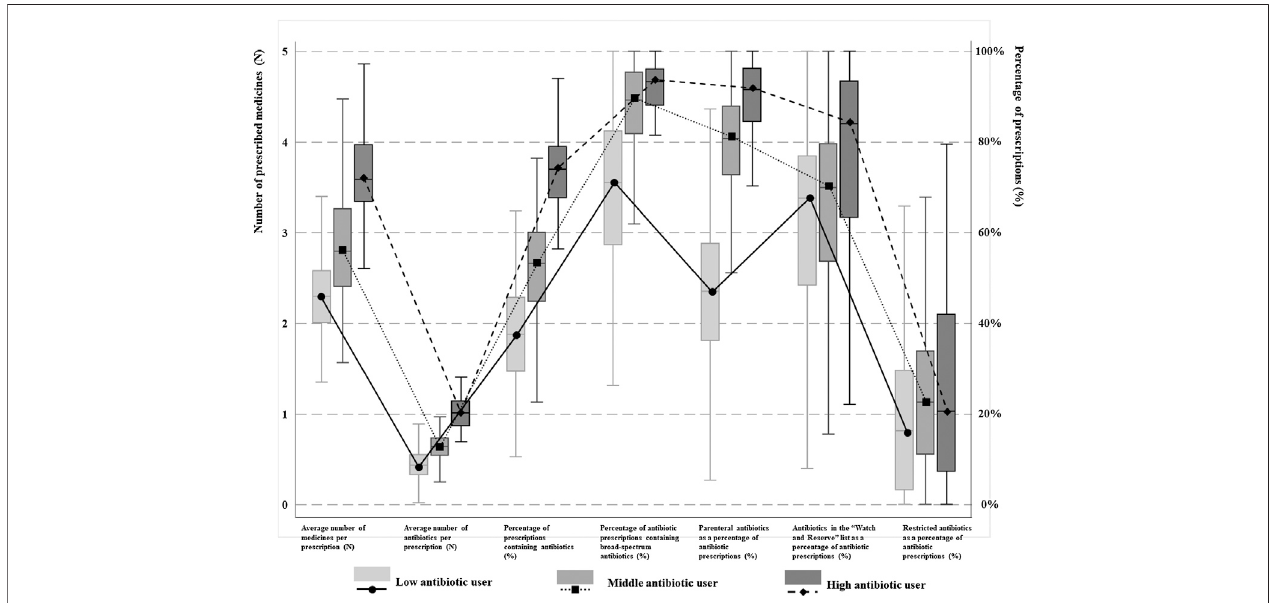
FIGURE1 | Antibiotic prescribing patterns among physicians indifferent groups. Three different kinds ofphysician ’ santibiotic prescribingpatternswere identi fi ed. Low, medium and highantibioticusers wereclassi fi edbasedonseven indicatorsregardingtorationaluseofantibiotics andwaspresented asdifferentlines.The means and quartiles of different patterns of different indicators were showed as